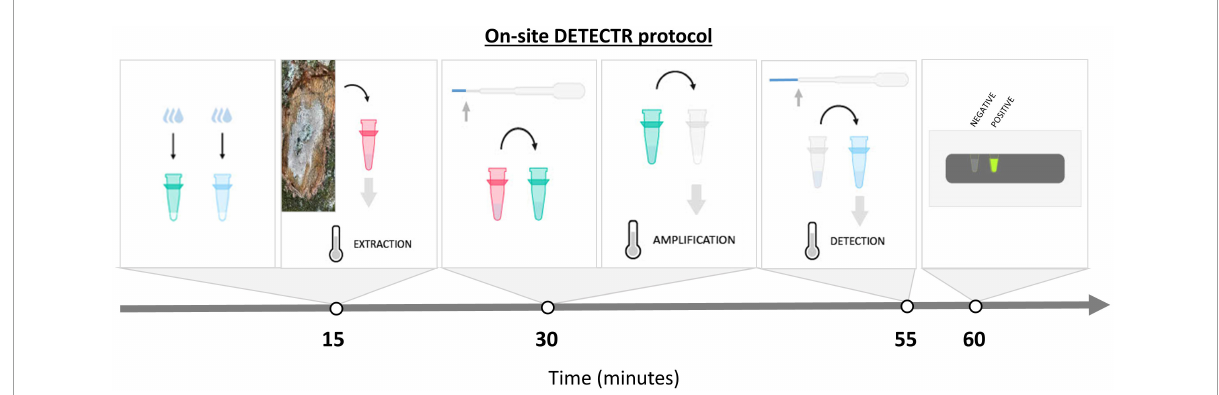
FIGURE1 Summary of the new and simplified on-site DETECTR assay. Amplification of target DNA by RPA, and detection by trans- cleavage release of fluorescence from the ssDNA FQ-reporter following CRISPR/CAS12a recognition of the target DNA. Each step is carried out in a specific colored microtube. All liquid handling is done via a simple transfer pipette. Reagents are either stable at room temperature or have been previously lyophilized to facilitate the deployment of the test. The equipment needed to perform the test is minimal and easy to carry into the field. A complete description of the protocol is available in Supplementary File 3